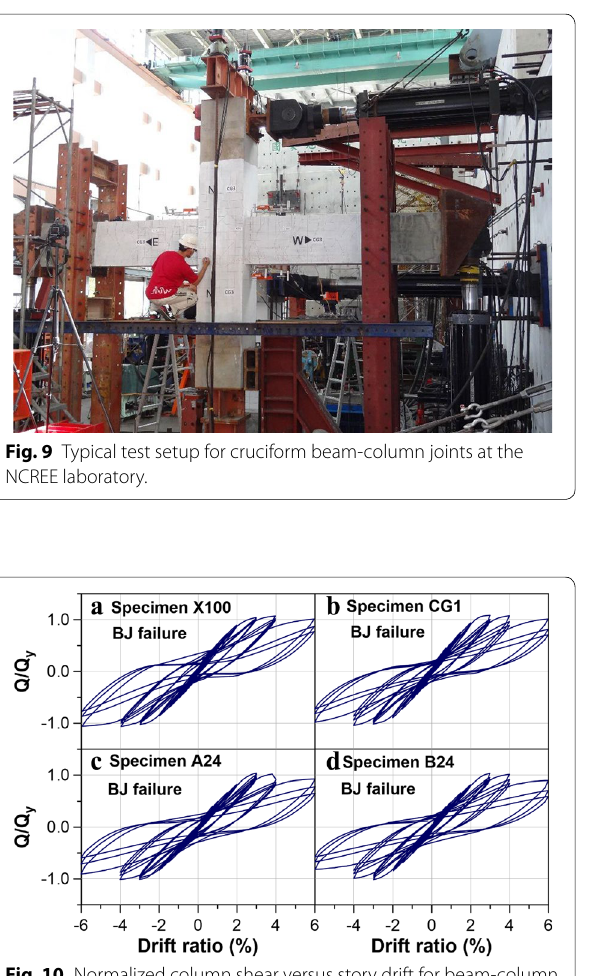
Fig. 10 Normalized column shear versus story drift for beam‑column joints tested at NCREE with h c / d b = 24